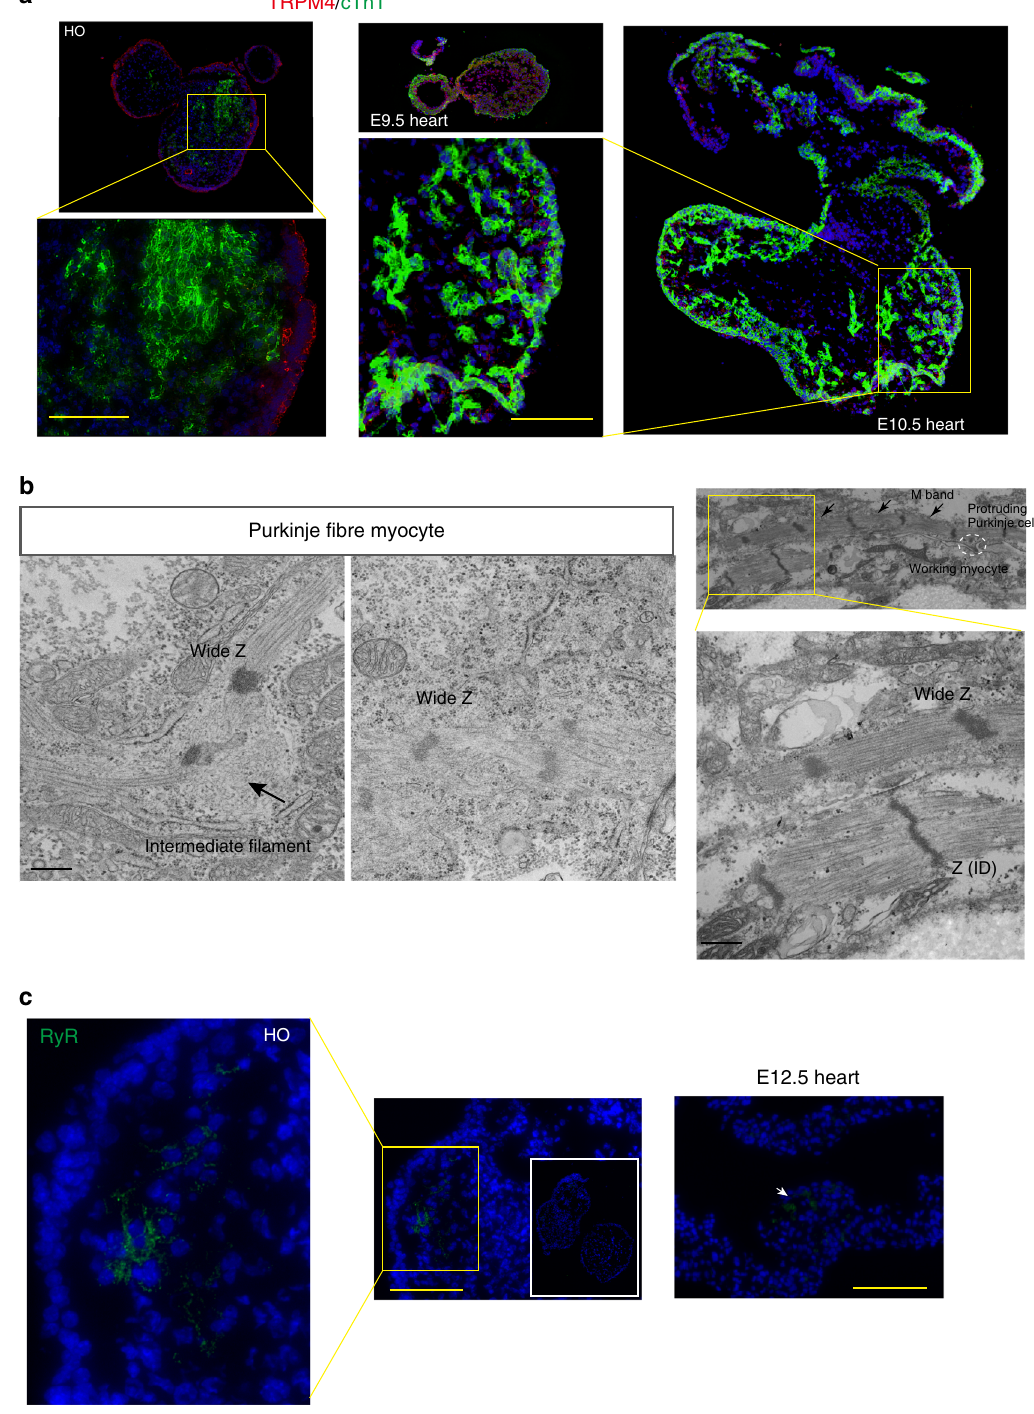
Fig. 6 Purkinje cells and T-tubule-associated components in heart organoid (HO)s. a Immunostaining to detect TRPM4 (red), a Purkinje cell marker, and cTnT (green) in HOs (left panels, n = 14, two independent experiments) and in E9.5 and E10.5 hearts (right panels). Scale bar: 100 μ m. b Purkinje-speci fi c myocytes in the HOs (over n = 3, over two experiments). A wide Z band, abundant intermediate fi laments, and/or sparse myo fi brils were observed (left panels). Both Purkinje cells (M bands (arrows) and wide Z bands) and working (ordinary) myocytes in the HOs were observed together in cell-to-cell contact, showing the protrusion of Purkinje cells (white dotted circle) into working myocytes (right panels). Scale bar: 400nm. c RYR2 immunostaining in the HOs (left and middle panel, n = 13, three biologically independent experiments) and an E12.5 heart (right). Inset indicates an entire section of the HO. Scale bar: 100 μ